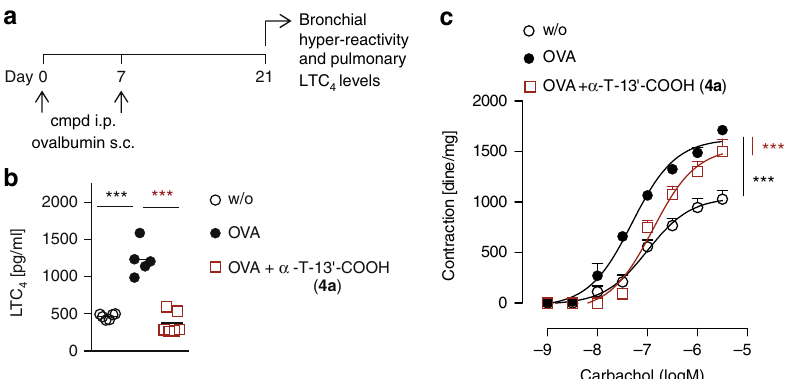
Fig. 6 α -T-13 ′ -COOH ( 4a ) inhibits bronchial hyper-reactivity in OVA-sensitized mice. a Time-scale for sensitizing mice with OVA. Cmpd, compounds. b , c Vehicle (DMSO) or α -T-13 ′ -COOH ( 4a ) (10 mg/kg, i.p.) were given to mice prior to injection of OVA (100 µ g adsorbed to 3.3 mg of aluminum hydroxide gel, s.c.) at days 0 and 7. Pulmonary LTC 4 levels ( b ) and bronchial reactivity to carbachol ( c ) were evaluated 21 days after administration of OVA. Mean + s.e.m. from n = 10 (w/o) or n = 6 (OVA, OVA + α -T-13 ′ -COOH, 4a ) mice. *** P < 0.001 vs. OVA-treated control mice; two-way ANOVA